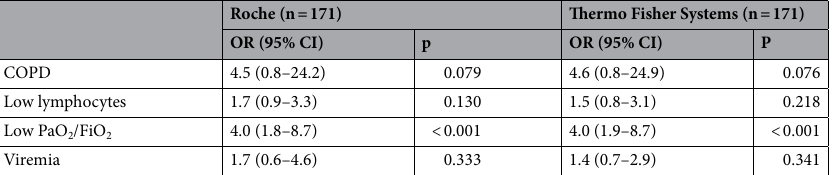
Table 2. Variables predicting the need for Intensive Care Unit admission. COPD: chronic obstructive pulmonary disease; CI: confidence interval; OR: odds ratio; PaO 2 /FiO 2 : arterial oxygen tension–fraction of inspired oxygen ratio.